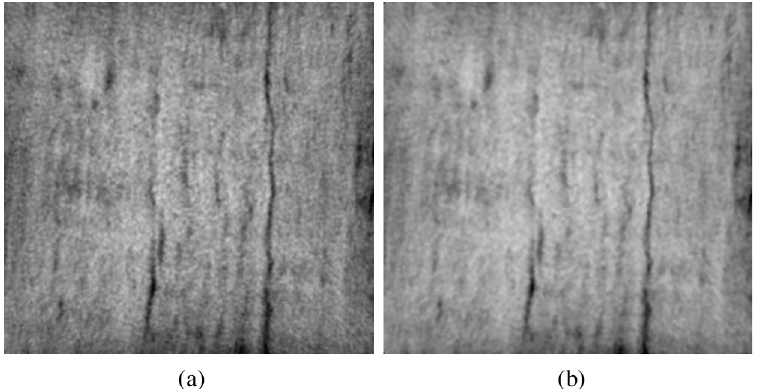
Fig 4. Image comparison before and after median